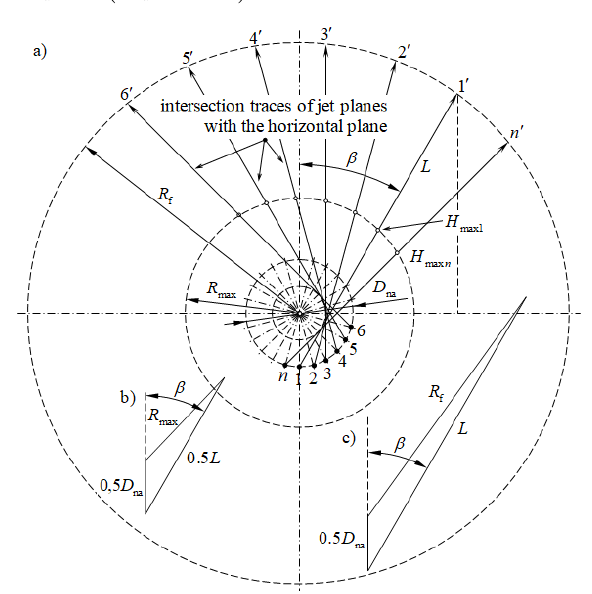
Fig. 5. Top view of fountain – basic dimensions